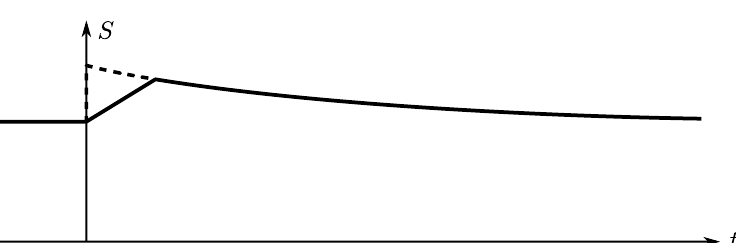
Figure 2 . Qualitative plot of the system’s coarse-grained entropy (dashed line) and the entangle- ment entropy (solid line) in the presence of an instantaneous